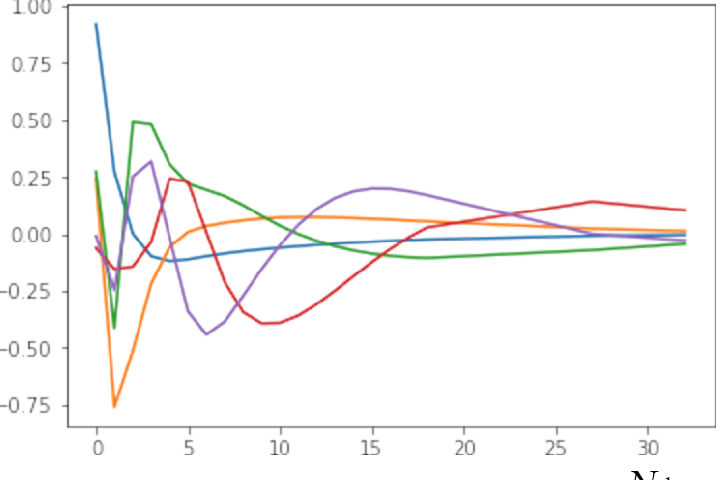
Figure 12. Example of a principal component decomposition of charged multiplicity distribution in pp collisions at 2.36